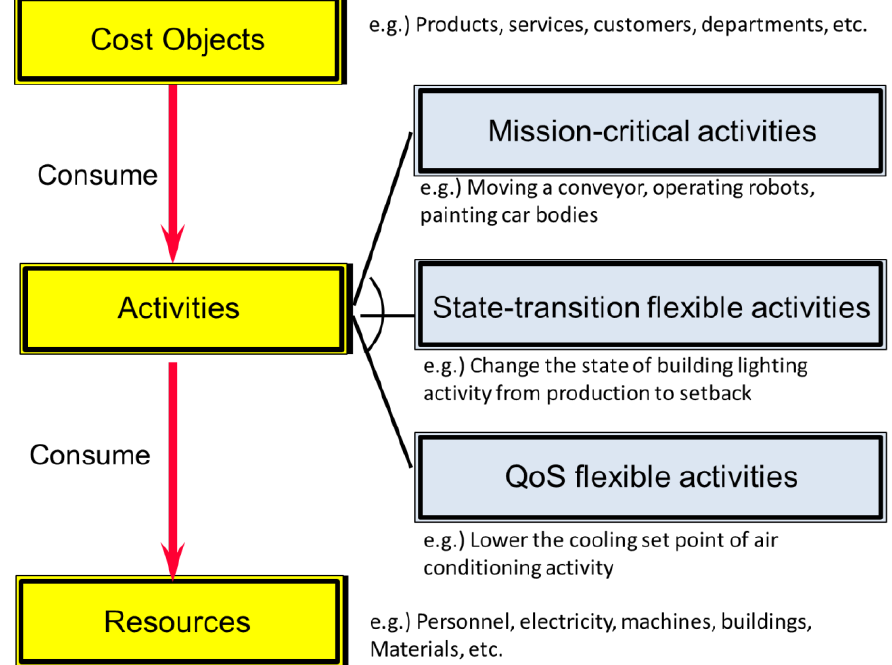
Figure 2. ABC costing model and three different sets of